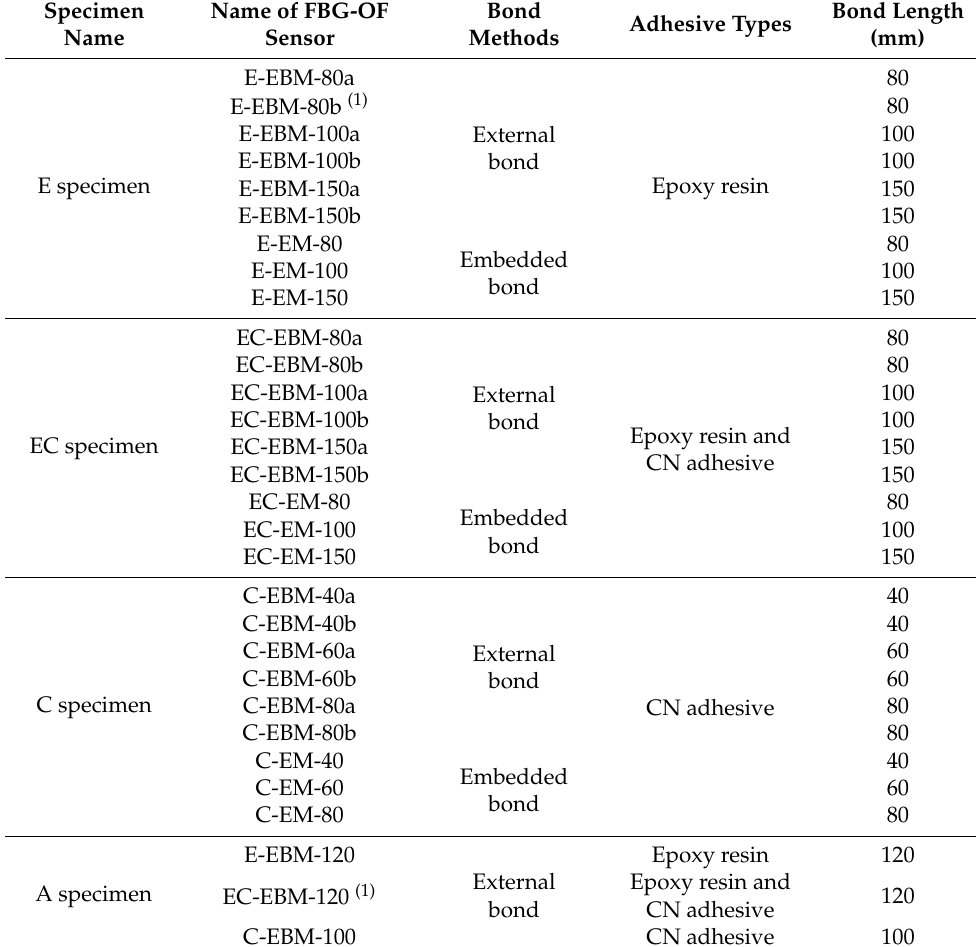
Table 3. List of parameters of FBG-optical fiber sensors bonded on FRP